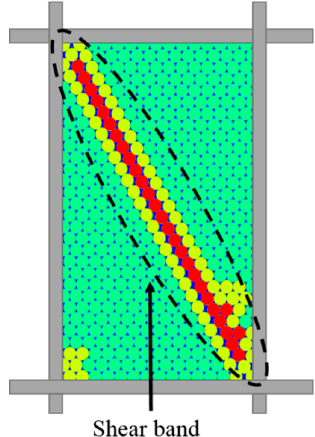
Figure 7. Shear band after macroscopic failure of cemented granular media in the biaxial compression simulation.